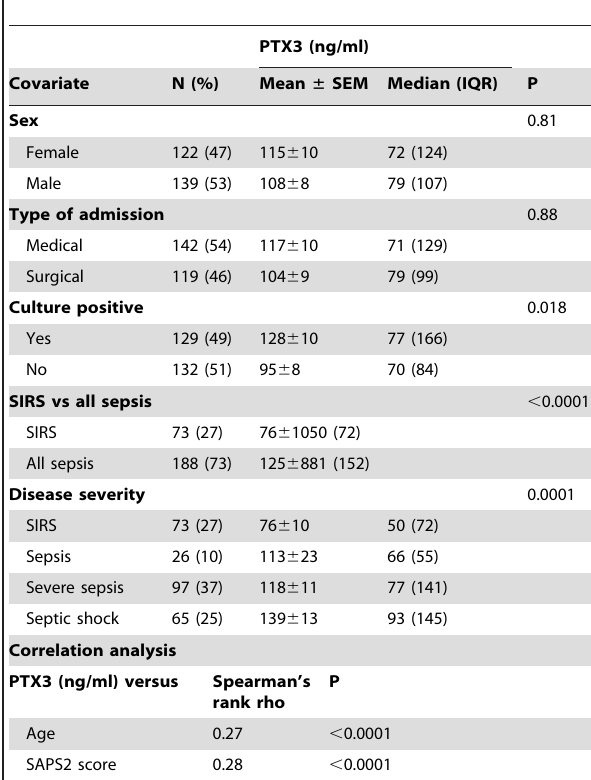
Table 2. Serum concentrations of PTX3 according to baseline